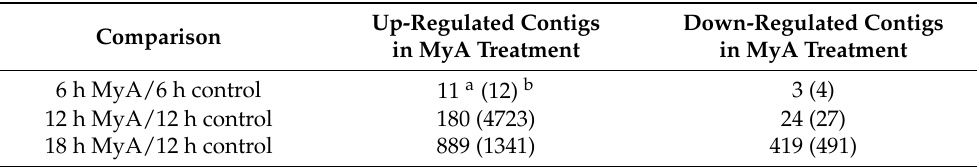
Table 1. The number of differentially expressed transcript contigs from the pairwise comparison in the Lepidium sativum seed transcriptome datasets (see Data S1 and S2 for specific contig details). Comparison